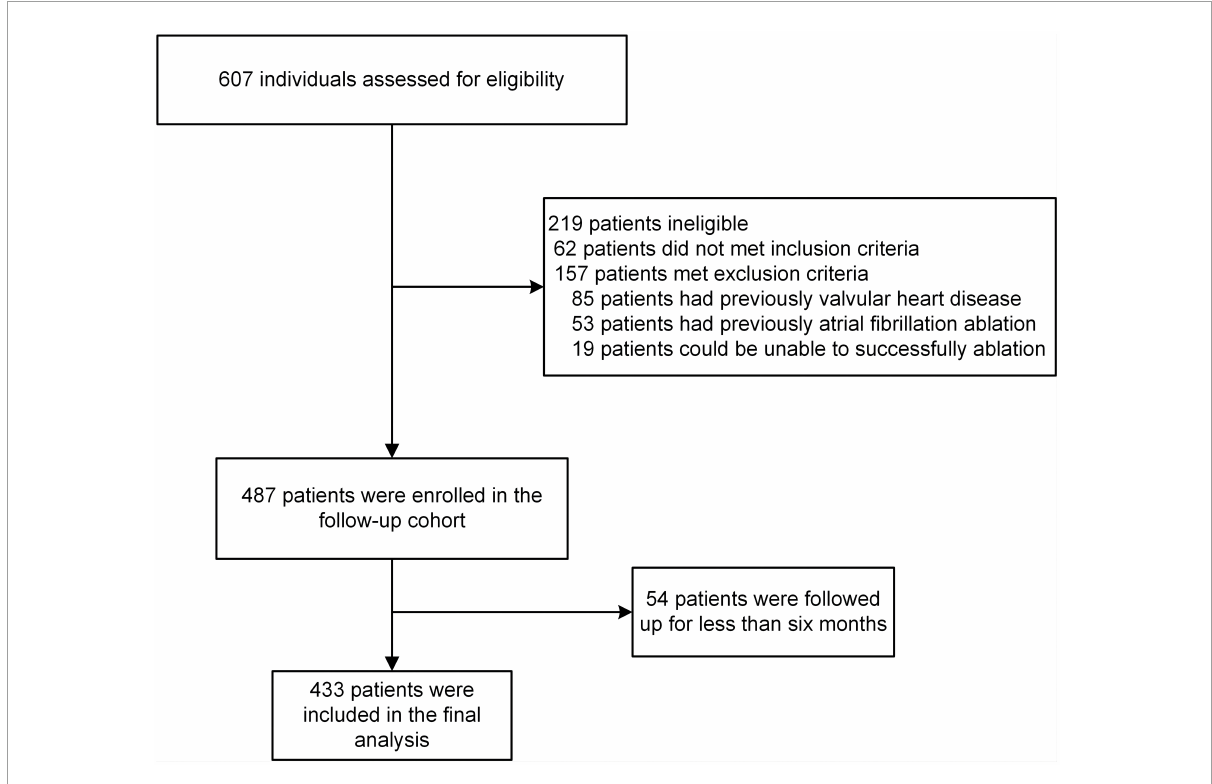
FIGURE1 Patient was screened and followed